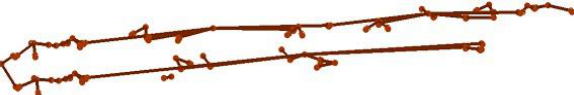
Figure 21. Navigable space (state and transition geometries) according to the flying locomotion